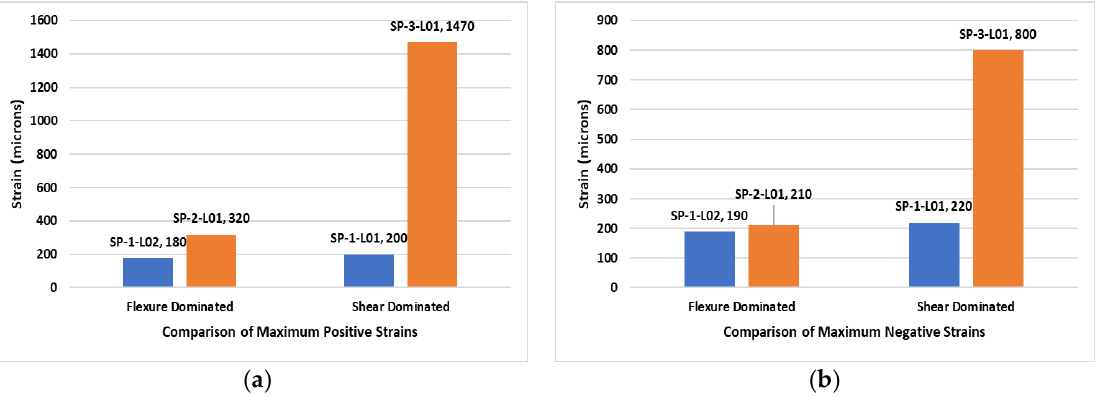
Figure 21. Comparison of strain under two-point service load ( a ) positive and ( b ) negative strain. Comparison between SP-1-L01 and SP-3-L01